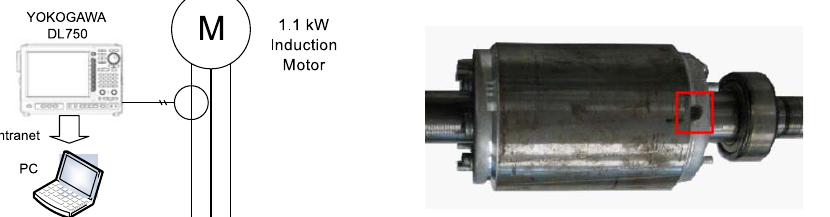
Figure 10. Experimental setup: measurement equipment ( left ), and rotor of the motor whose characteristics are given in Appendix A, with a broken bar ( right